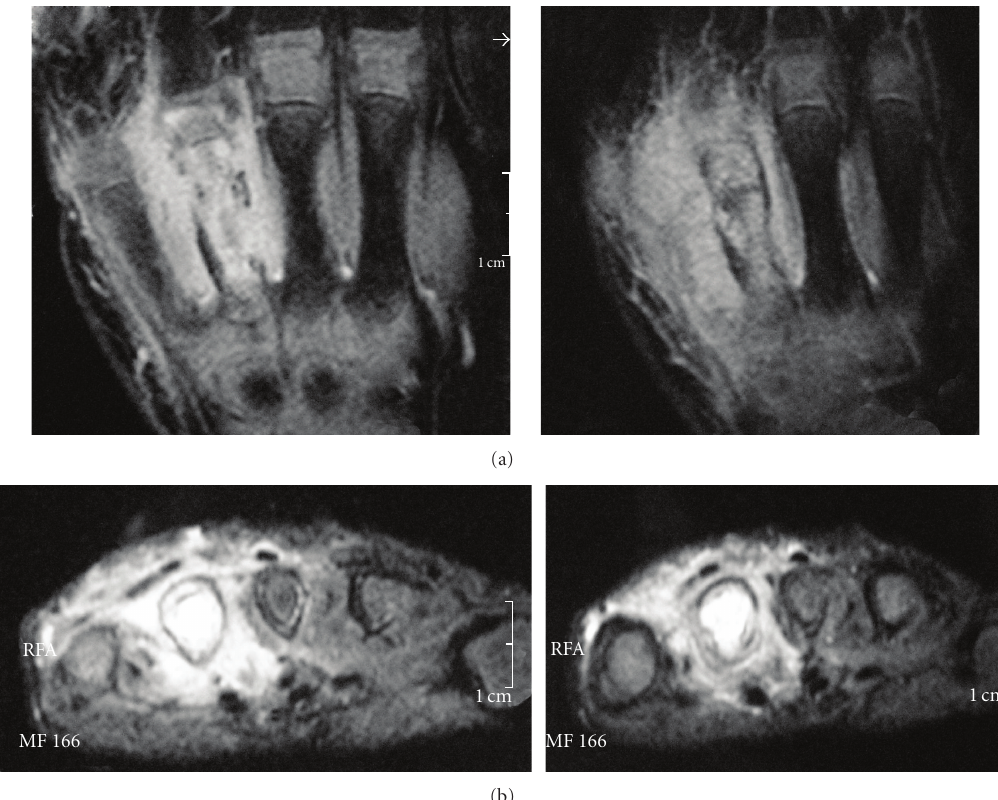
Figure 3: MRI findings, diaphyseal and physeal destruction, and bone oedema and soft tissue oedema.